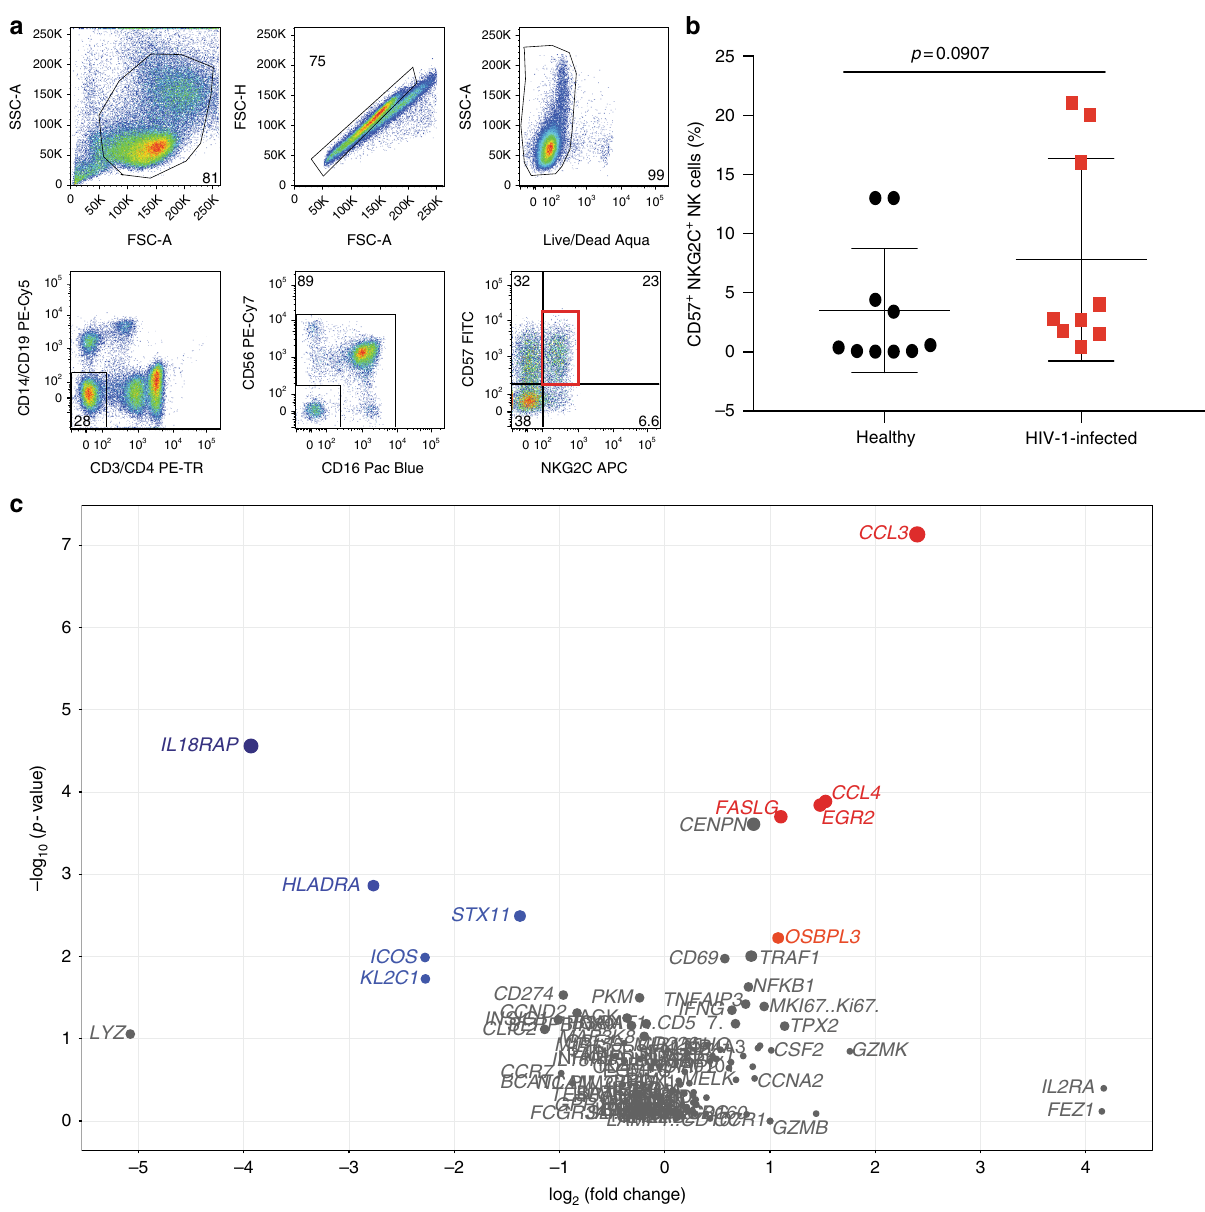
Fig. 7 Cell surface expression of NKG2C and gene expression of CD57 + NKG2C + NK cells in healthy subjects and HIV-1 chronically infected individuals. a Flow cytometric gating strategy of sorted CD57 + NKG2C + NK cells. b Graphical analysis of frequency of CD57 + NKG2C + NK cells in healthy (black) and HIV-1-infected individuals (red). Mann – Whitney test was used to determine signi fi cance between frequencies of each group. c Volcano plot displaying upregulated (red), downregulated (blue), and stably expressed (gray) pre-selected genes, involved in NK cell-mediated responses to HIV-1 infection. Size of each data point is calculated as − log 10 ( p -value) × log 2 (FC), p -value cutoff p < 0.05, fold change cutoff > 2 or <1/2. Transcriptional analysis from